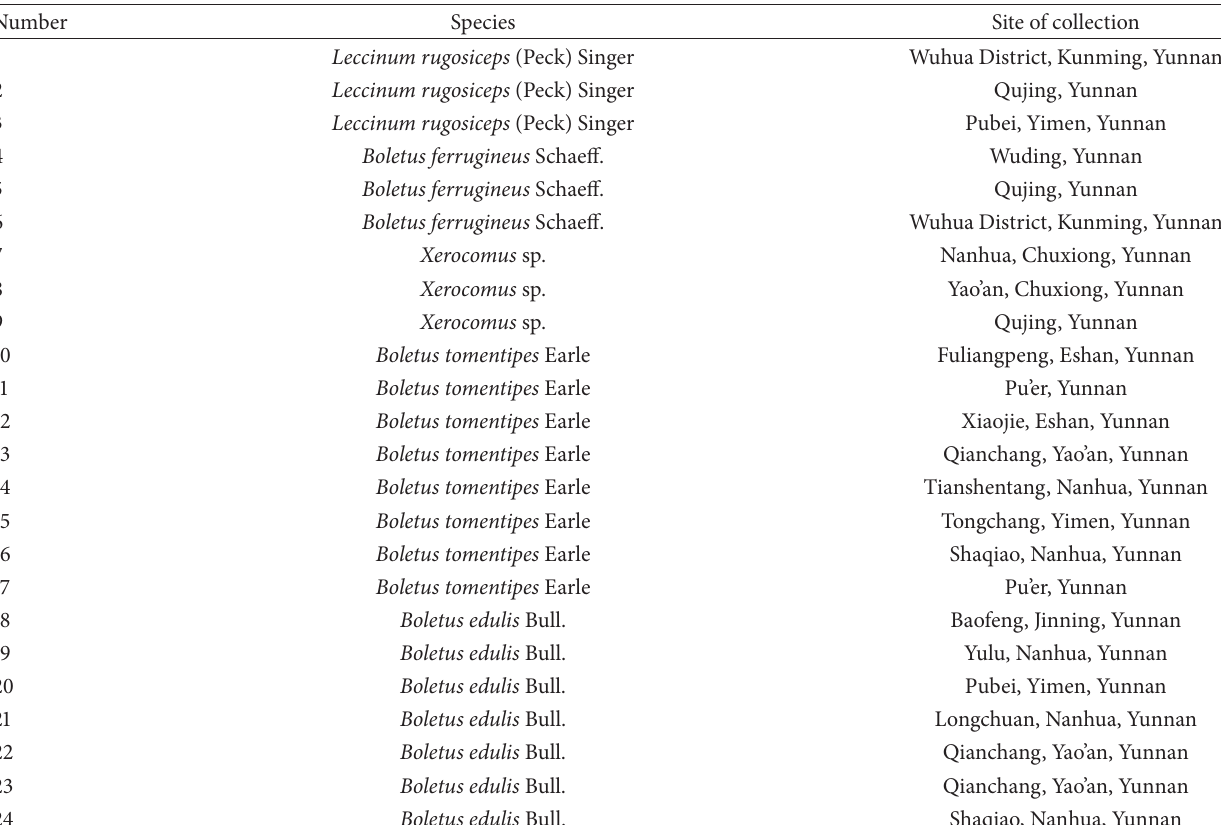
Table 1: Information of all the